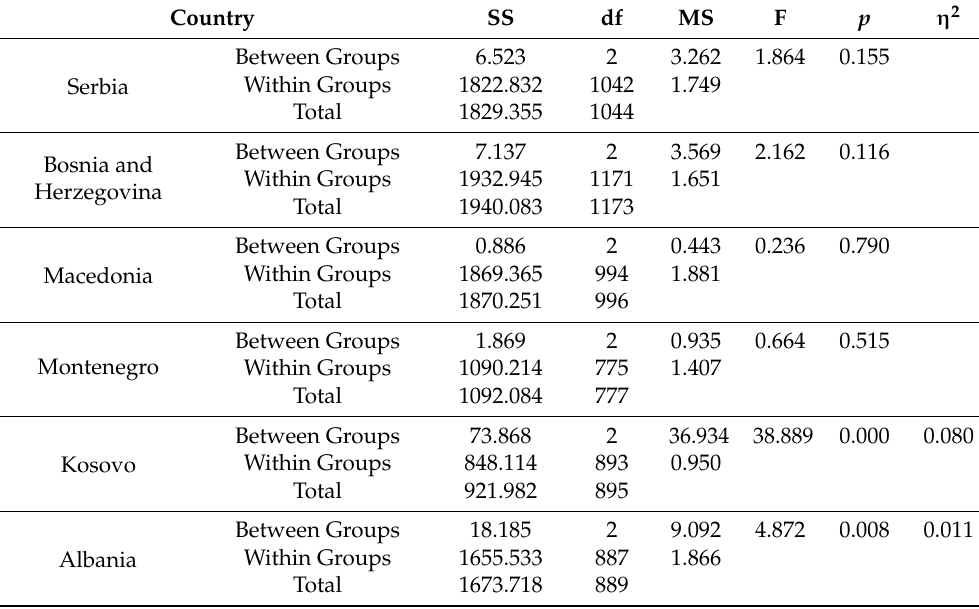
Table A14. Using connections for getting things done among confessions by country.